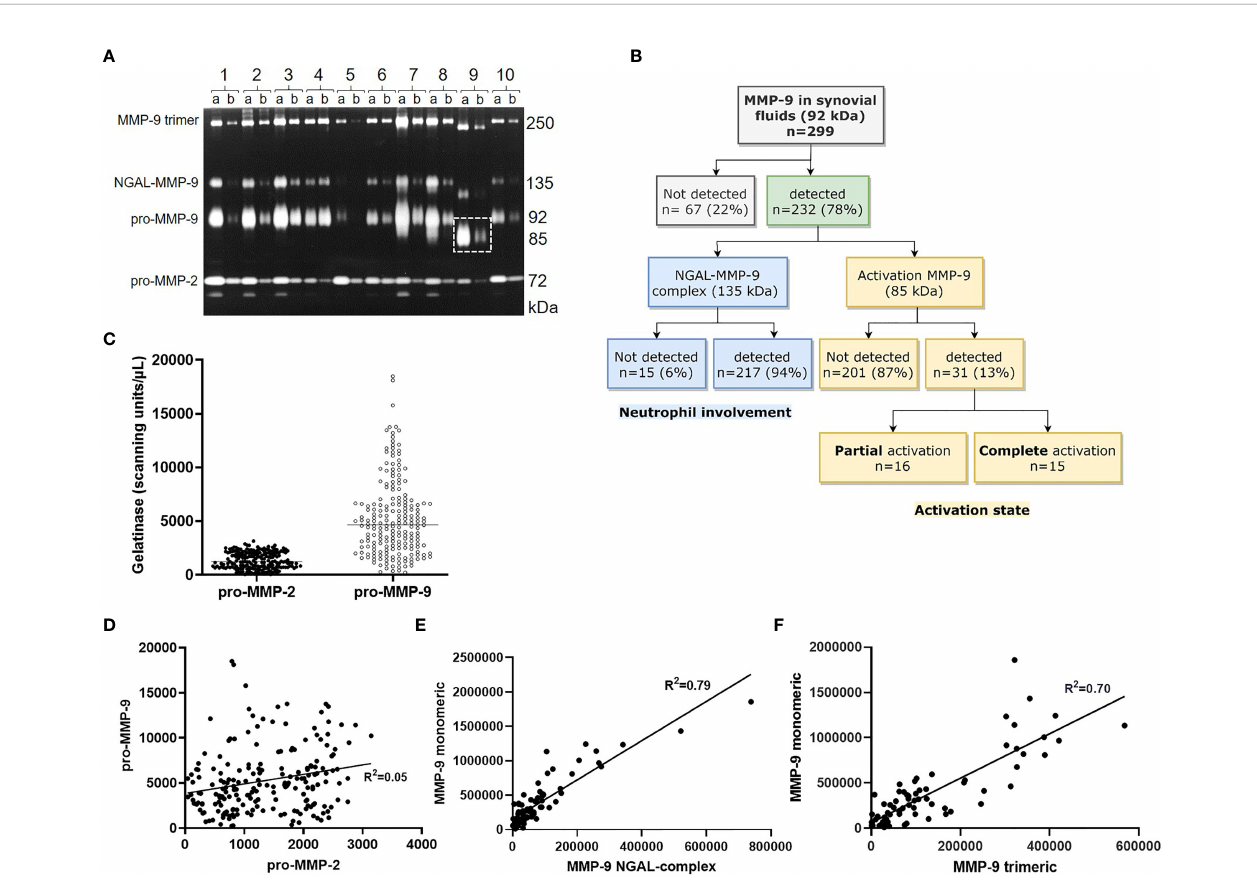
FIGURE 1 | Synovial fl uid analysis with the use of gelatin zymography. Diluted synovial fl uids, 1/10 (lanes a) and 1/100 (lanes a) , were analysed by gelatin zymography. Sharp bands at 72 kDa represent pro-MMP-2, whereas unsharp 92 kDa bands correspond to monomeric pro-MMP-9 glycoforms. NGAL binds pro- MMP-9 and yields gelatinolysis around 135 kDa. Homotrimers migrate at approximately 250 kDa, whereas activated proteoforms (lane 9a and 9b) contain monomers at 85 kDa (dashed rectangle) (A). Flowchart with proteoform detection in a historical patient cohort (B). proMMP-9 levels vary considerably more compared to proMMP-2 (C) and appear unrelated (n=200, r 2 = 0.05) (D) . Monomeric MMP-9 levels correlate with amounts of NGAL-complexed MMP-9 (n=72, r 2 = 0.79; p<0.0001) (E) and with MMP-9 homotrimers (n=71, r 2 = 0.70; p<0.0001) (F)